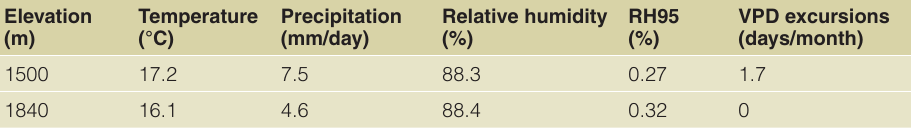
Table 1. July climate for weather stations within 1 kilometer of the transplant sites. Values represent the mean for July in 2007, 2008, and 2009, except for precipitation, which does not